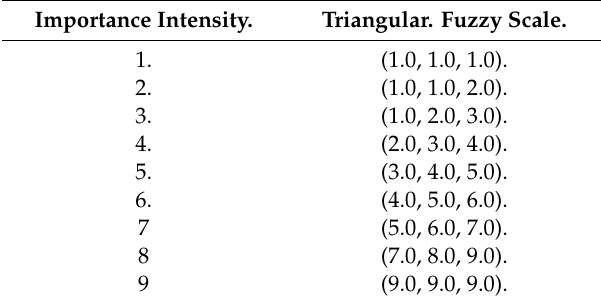
Table 2. The 1–9 fuzzy conversion